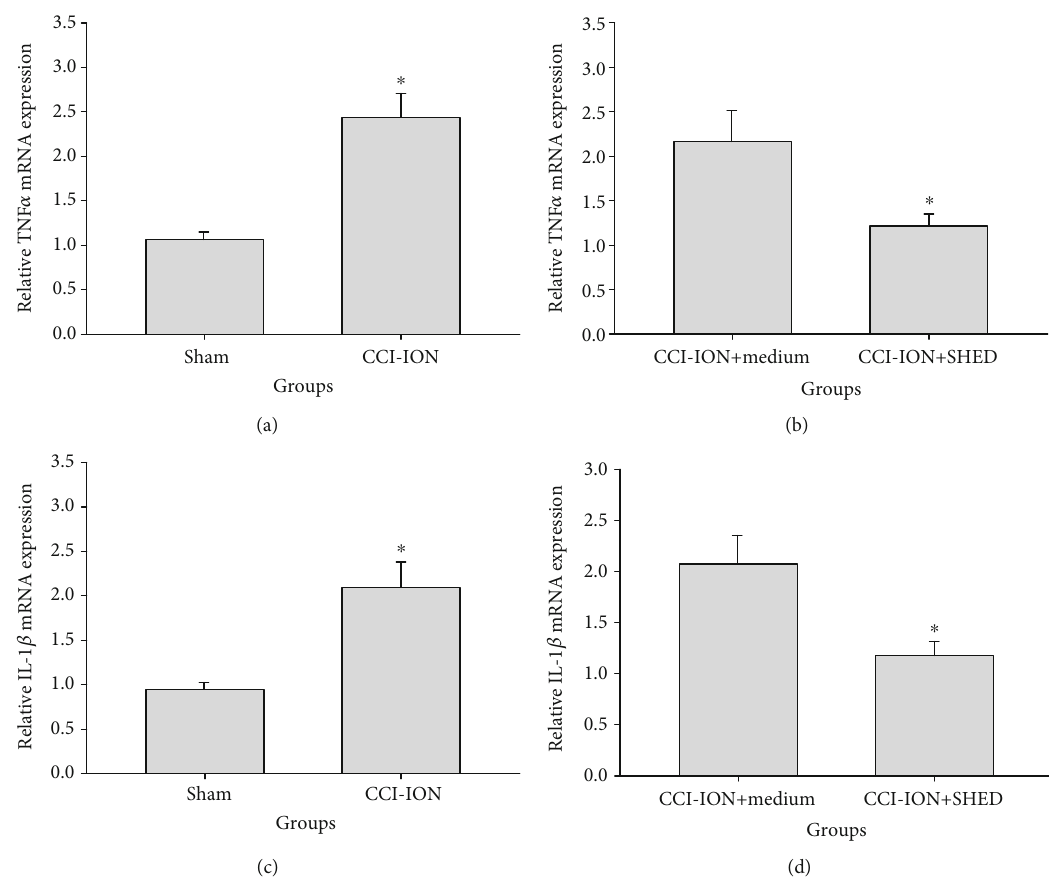
Figure 5: Local SHED transplantation reduces TNF- α and IL-1 β mRNA levels in the trigeminal nerve 7 days after transplantation. mRNA levels of TNF- α (a) and IL-1 β (c) in the injured trigeminal nerve measured 7 days after CCI-ION. mRNA levels of TNF- α (b) and IL-1 β (d) in the injured trigeminal nerve measured 7 days after local SHED transplantation ( 1 × 10 5 cells, 0.2 mL). ∗ p < 0 : 05 vs. sham (a, c), ∗ p < 0 : 05 vs. medium (b, d). All data are expressed as the mean ± SEM ( n = 6 rats in each